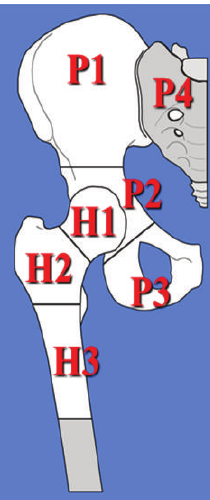
Figure 2: Pelvic and proximal femoral resections according to Enneking and Dunham’s